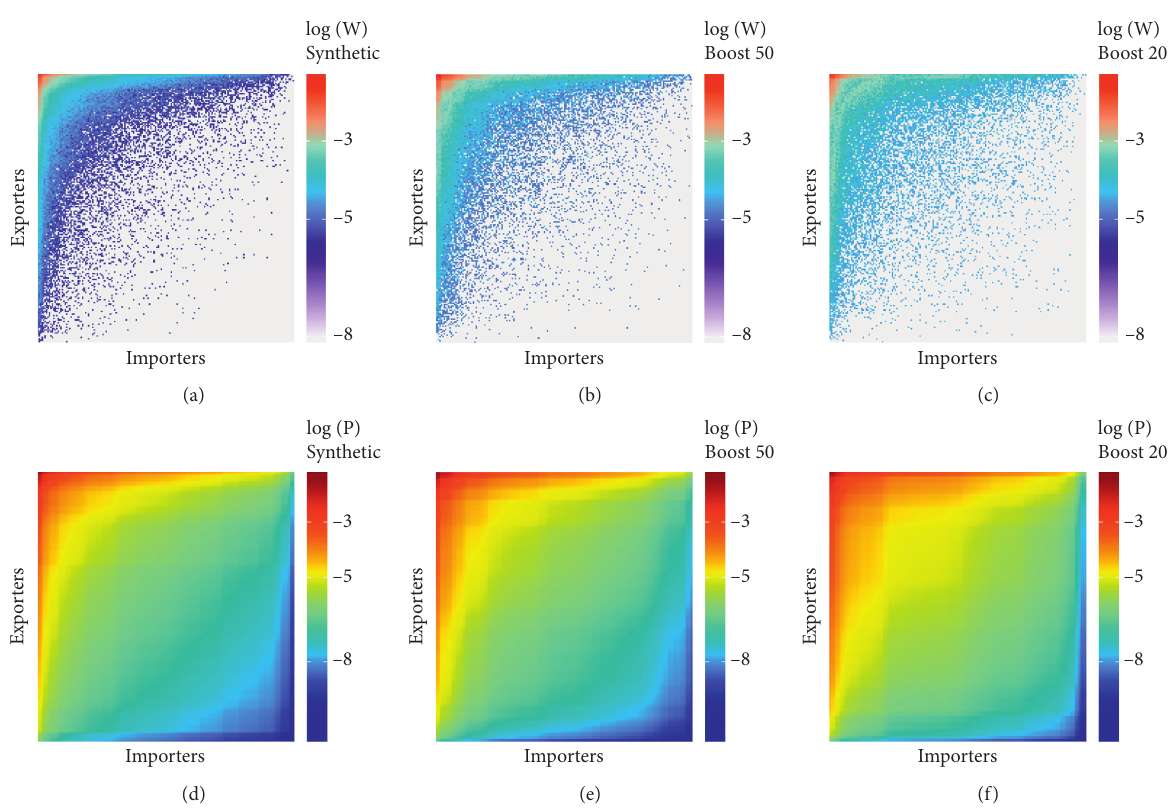
Figure 3: Synthetic matrices for year 2011. (a) Normalized weight network. (b) Result with 50% boosted probability for the lower 2% of global trade, with no regional restrictions. (c) The same with 200% boosted probability. Under these three plots (d), (e), and (f) are the heat maps of each corresponding final probability